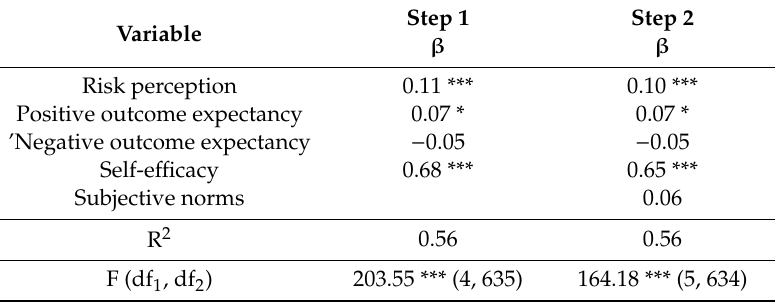
Table 2. Summary of hierarchical regression analysis of variables predicting